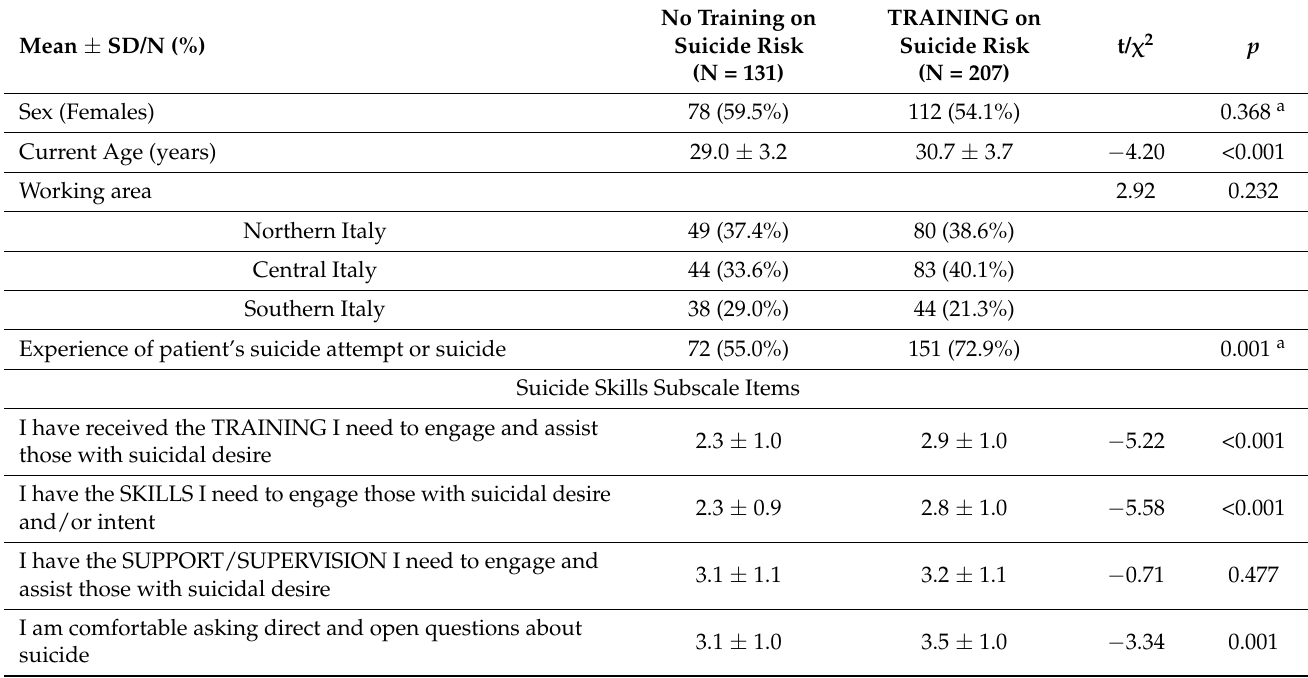
Table 2. Differences between subgroups according to training on suicide risk (general characteristics and suicide-skills subscale